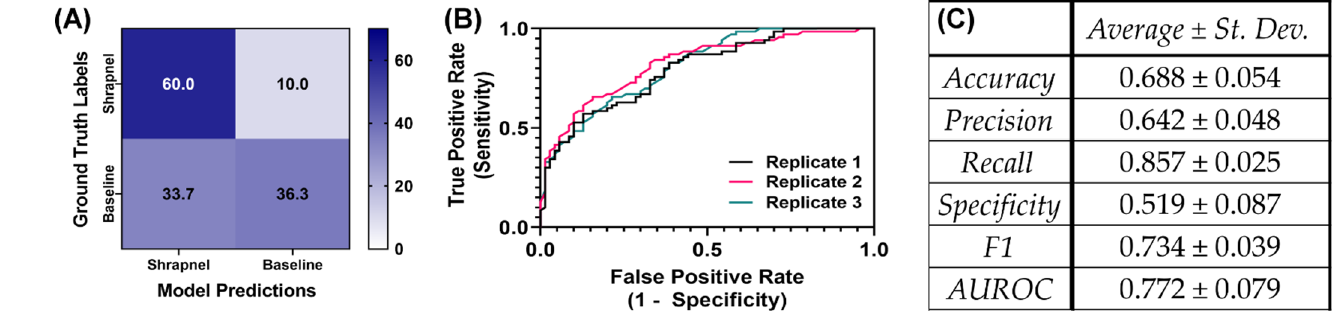
Figure 4. Gradient-weighted class activations mapping overlays for the initial ShrapML model. Rep- resentative images are shown with and without GradCAM overlays in a confusion matrix layout along with the prediction confidence. 3.2. Effect of Data Augmentation and Model Architechture on Improving Blind Subject Test Performance Initial training datasets were comprised of five tissue phantom subjects. These train- ing sets were configured into five leave one subject out (LOSO) training sets to make one of the five phantoms a blind validation subject for each training iteration. Using this meth- odology, the performance variability was evident for ShrapML, as accuracy varied from 0.688 to 0.755 (Table 1). More pronounced variability was evident with recall (0.538 to 0.857) and specificity (0.519 to 0.900), indicating various LOSO holdouts varied greatly in false positive and negative rate. These LOSO holdouts were used for the remainder of the study to better assess performance consistency for different blind test subjects.